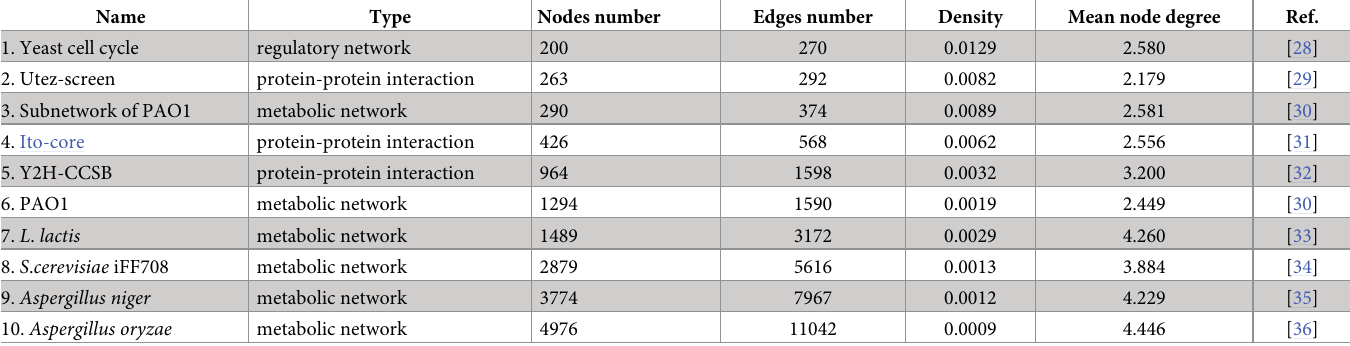
Table 1. The list of example networks used to evaluate the performance of selected algorithms. Name